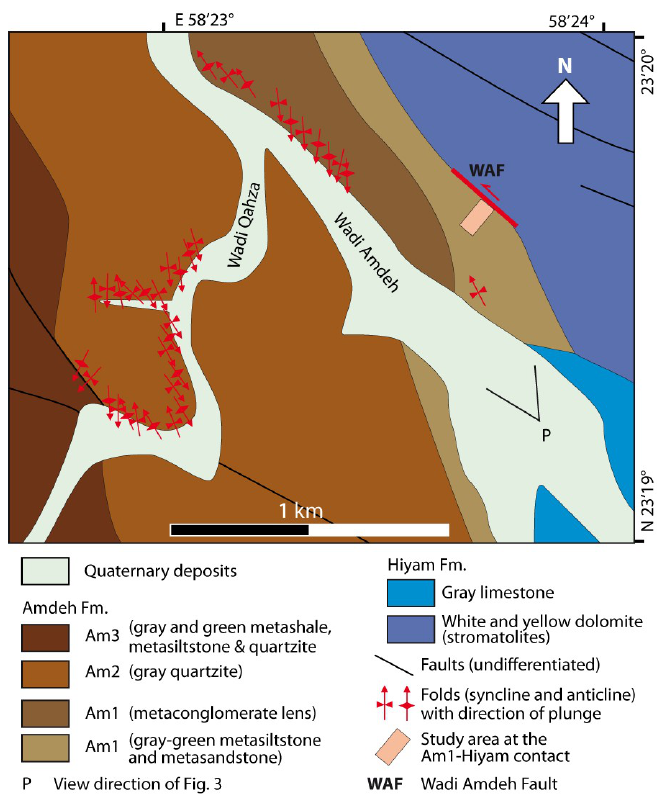
Figure 6. Geological map of the study area with fold locations and location of the contact between the Hiyam and Amdeh formations. Note that the faults in the Hiyam Formation strike similarly to the Amdeh Fault. Partly drawn after [15].